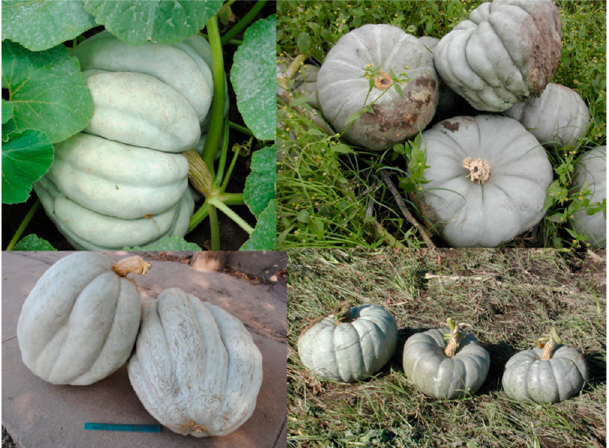
Figure 10. Fruits of Plomo cultivar ‐ group. Lower row, left globular, right flattened type. Blue ruler length 20 cm.